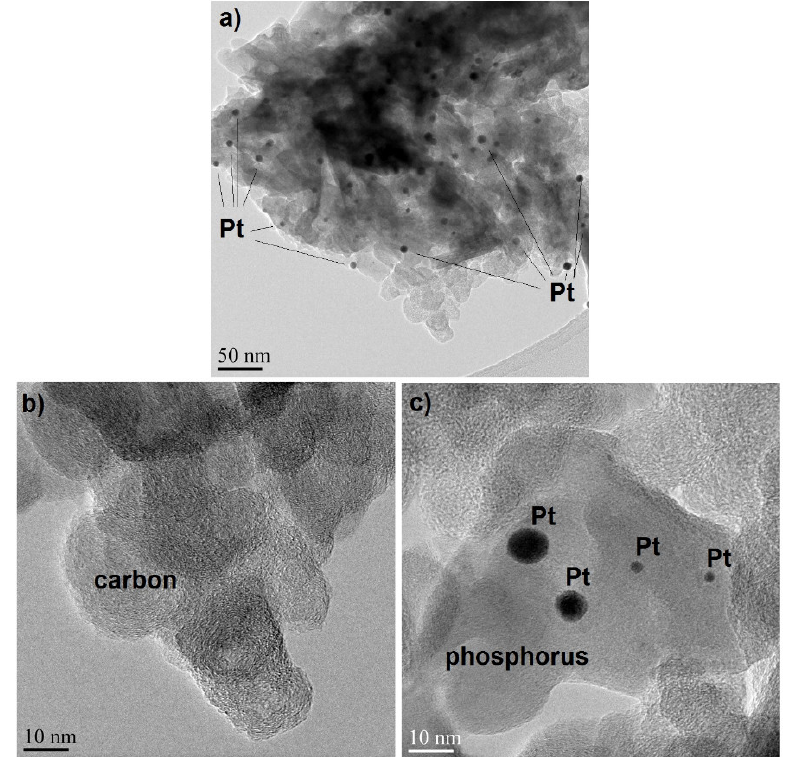
Figure 4. TEM images from ( a ) the vehicle-aged diesel inlet catalyst. ( b ) and ( c ) showing the carbon and phosphorus poisoned areas, respectively.